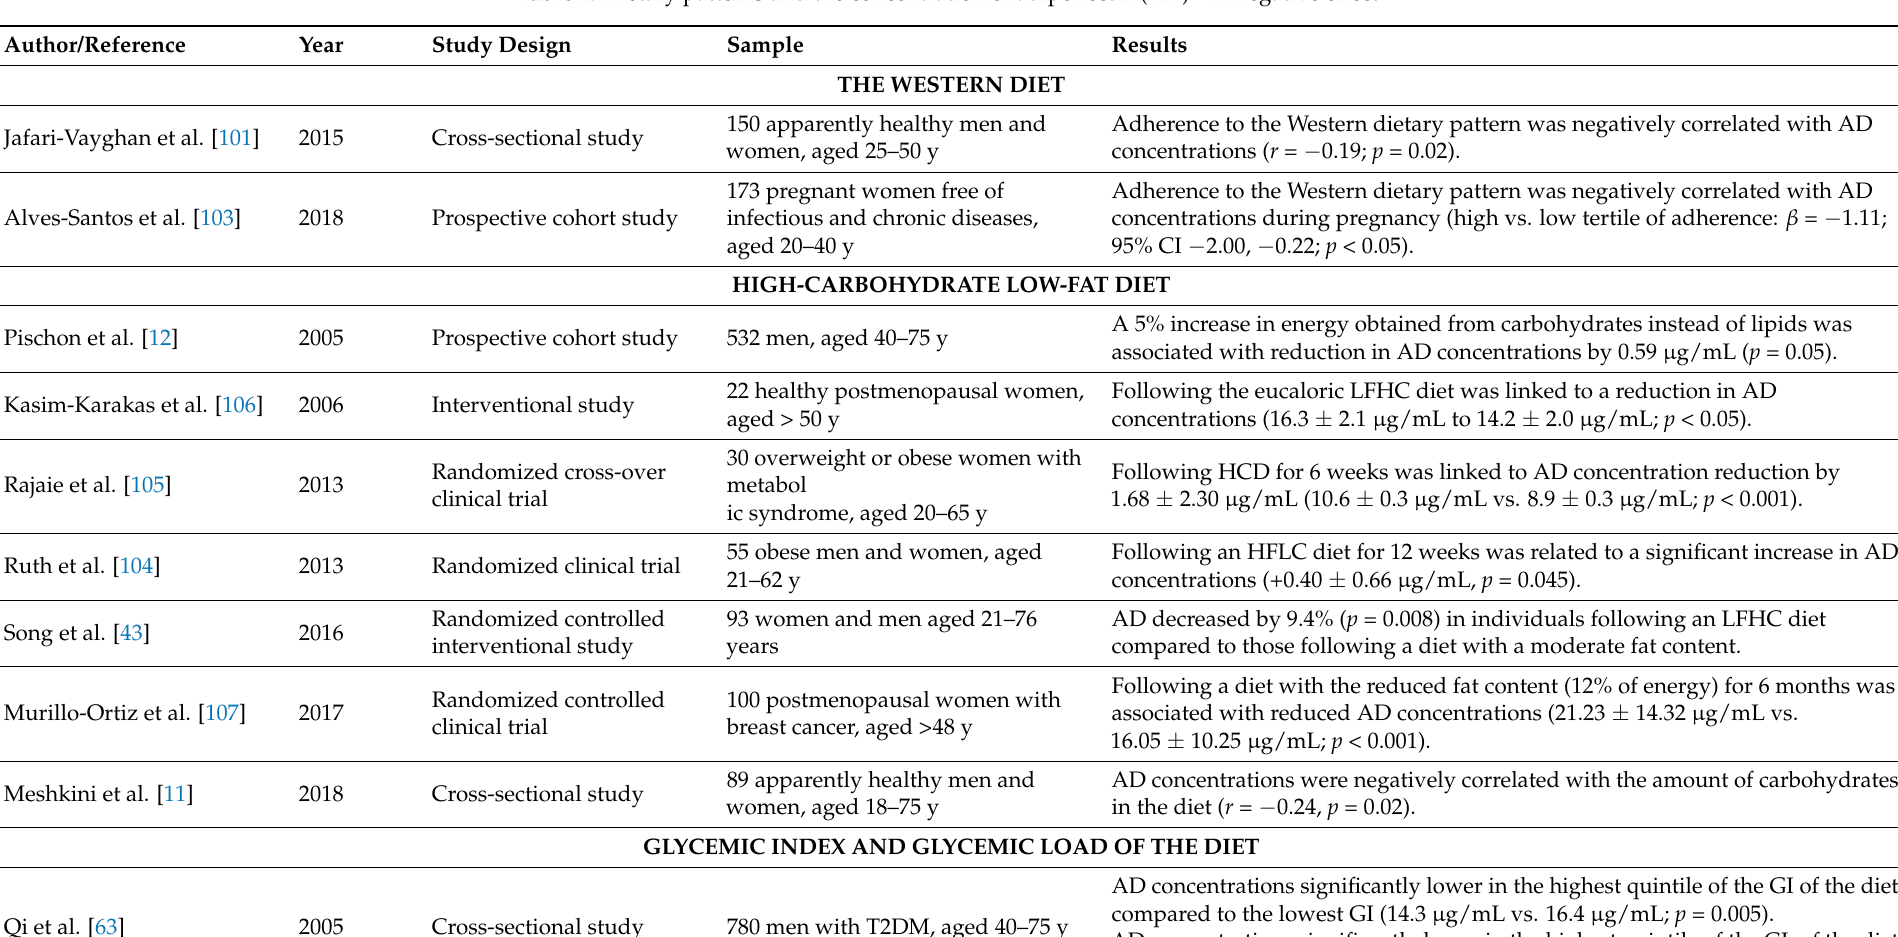
Table 2. Dietary patterns and the concentration of adiponectin (AD)—A negative